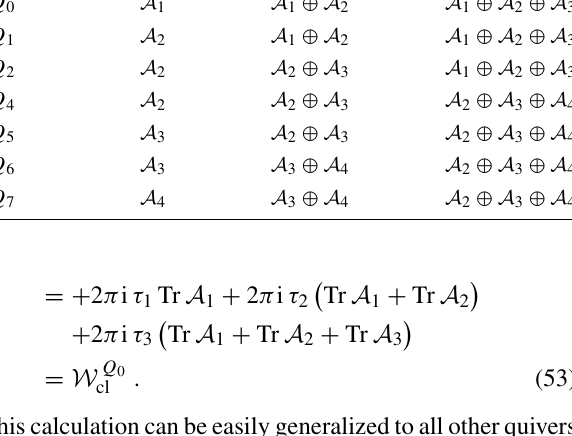
Table 1 For each of the quivers in Fig. 8, we list the classical expec- tation values of the twisted chiral fields in each of the three 2d nodes. Using them in the classical twisted chiral superpotentials given in (43), one finds identical expressions